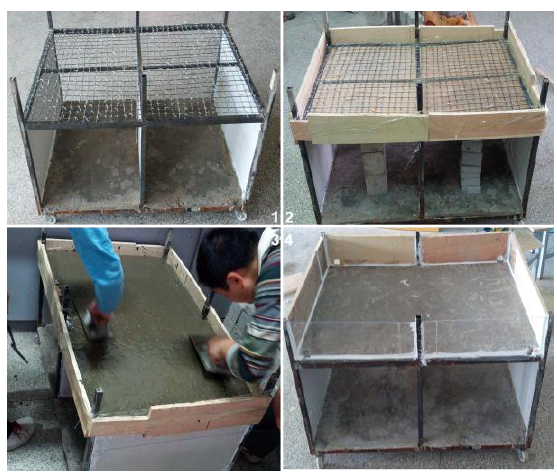
Figure 3. Assembling process of the experimental device.